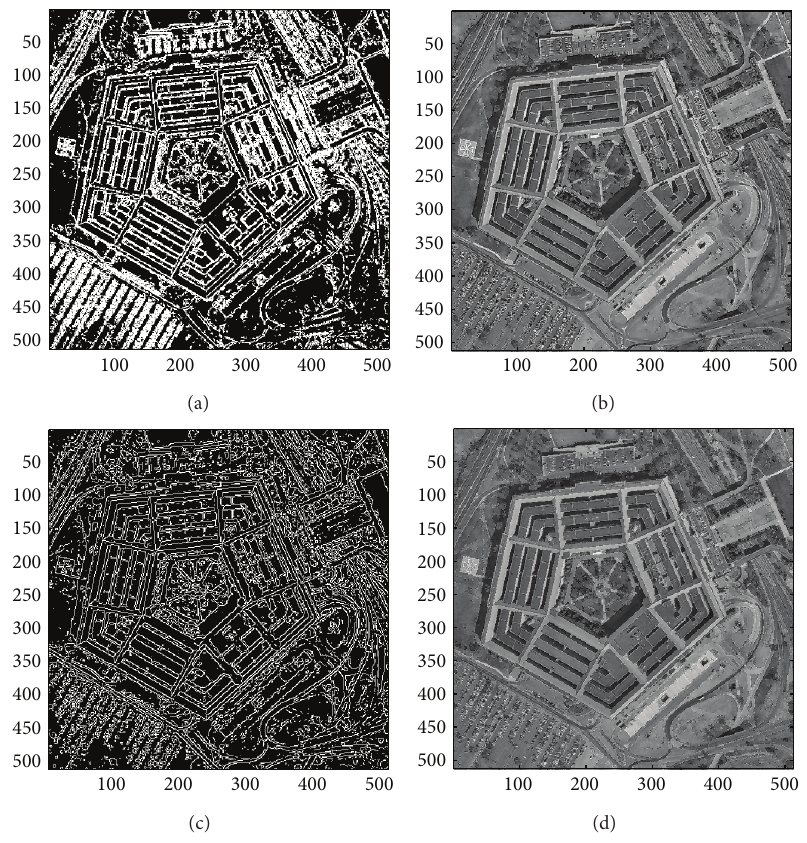
= 10 in the image “Pentagon.” (b) Result by HVD with scaling factor 𝑠 = 1.0 . (c) Edges Figure 12: (a) Edges detected by HVD with 𝜃 eth detected by Canny operator in the image “Pentagon.” (d) Result by Canny operator with scaling factor 𝑠 = 1.0